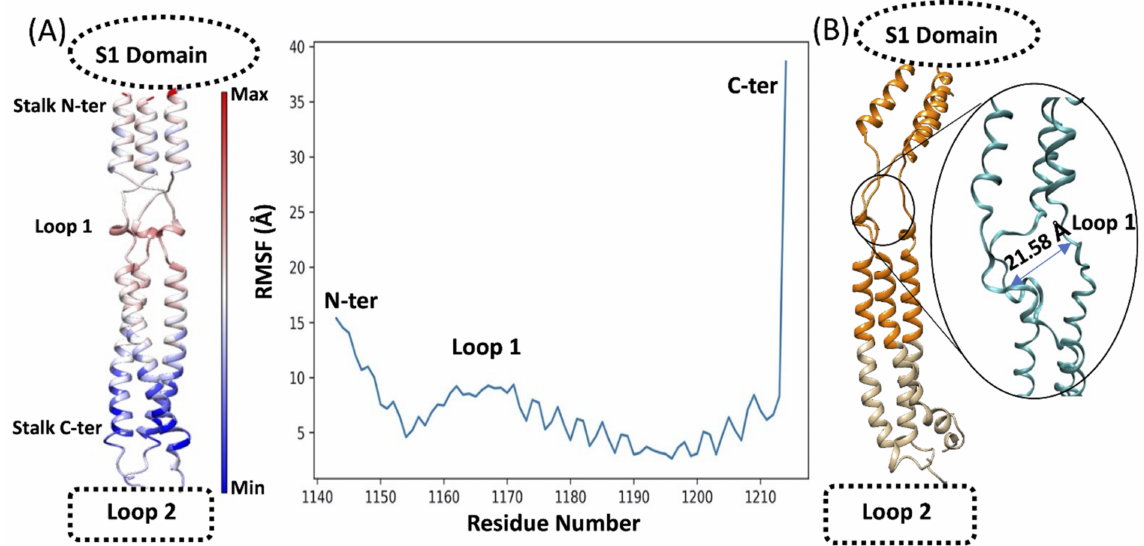
Figure 3. ( A ) Root mean square fluctuation (RMSF) of the SP stalk during cMD simulations. The RMSF of each residue is mapped on the structure (left panel) and color-coded according to the value (flexible residues are red); RMSFs are also plotted on the sequence (right panel); ( B ) the SP stalk Conserved Region 1 (orange) is subjected to high flexibility during cMD simulations at the level of Loop 1; the position of the S1 domain and the Loop 2 is reported for